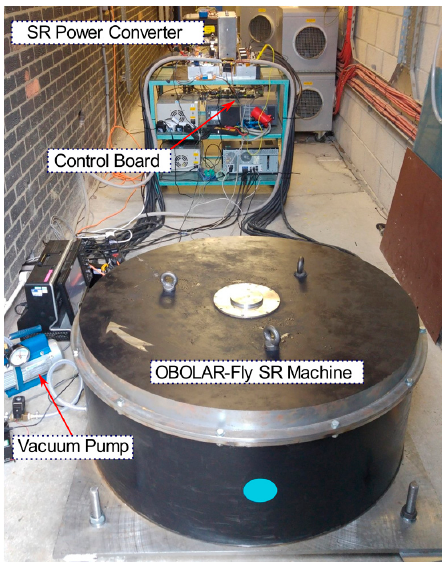
Figure 13. OBOLAR-FLY SR machine prototype test rig in its high-safety room.